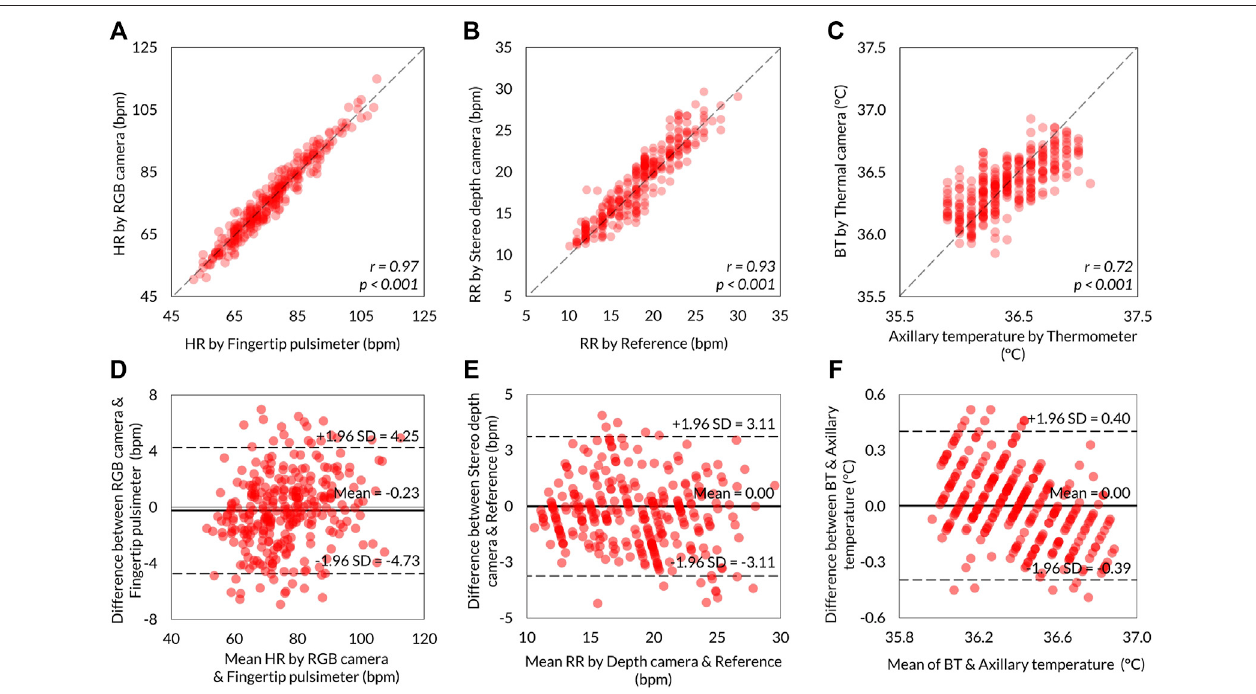
FIGURE 6 | Summary of the VISC-Camera ’ s vital signs measurement accuracy (n = 301). Scatter plots showing the relationship between VISC-Camera determinedvitalsignsandreferencevitalsignvalues. (A) HRwith r =0.97, p < 0.001,RMSE=2.7. (B) RRwith r =0.93, p < 0.001,RMSE=1.6. (C) BTwith r =0.72, p < 0.001,RMSE=0.2.TheBland – Altmanplotsillustrating95%limitsofagreementsofRR,HR,andBTmeasurementsbytheVISC-Cameraandthereferences. (D) ForHR, theRGBcameraand fi ngertippulsimeterrangedfrom − 4.7to4.2bpmvs.mean( σ =2.3). (E) ForRR,thestereodepthcameraandthereferencerangedfrom − 3.1 to 3.1 bpm vs. mean ( σ = 1.6). (F) BT and axillary temperature ranged from − 0.39 to 0.40 ° C vs. mean ( σ = 0.2).